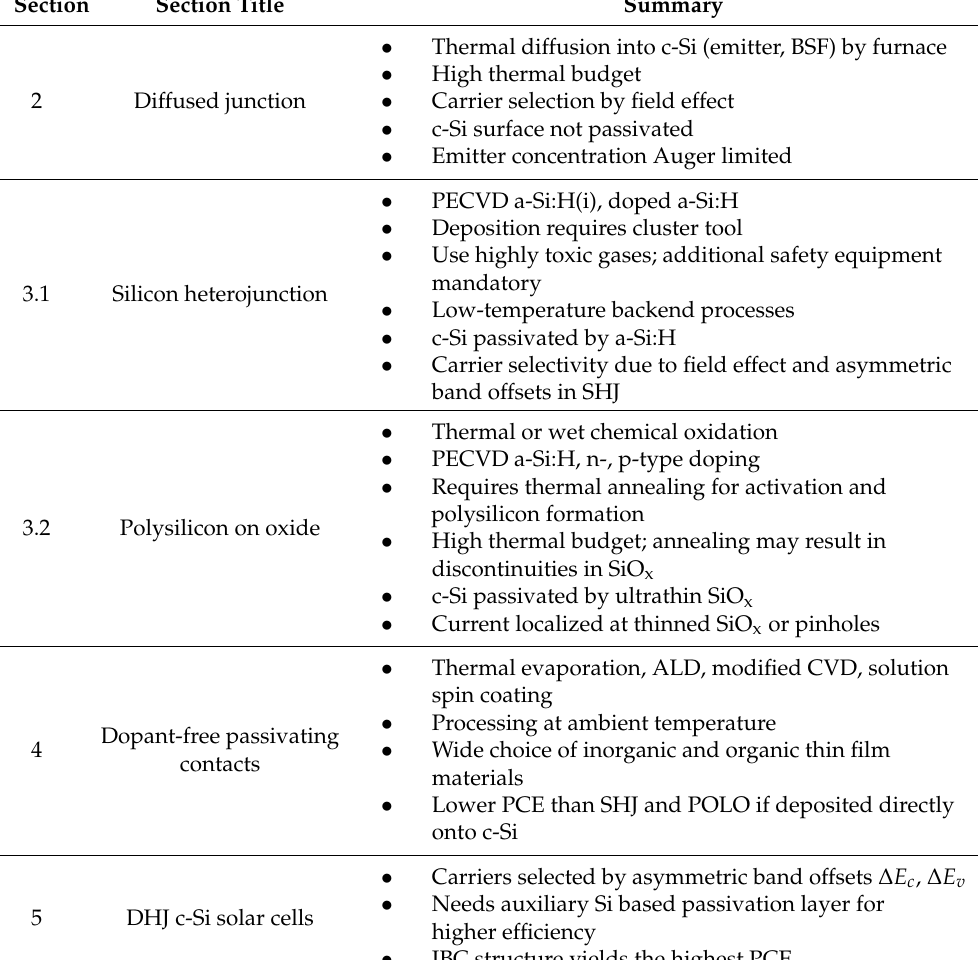
Table 2. Section